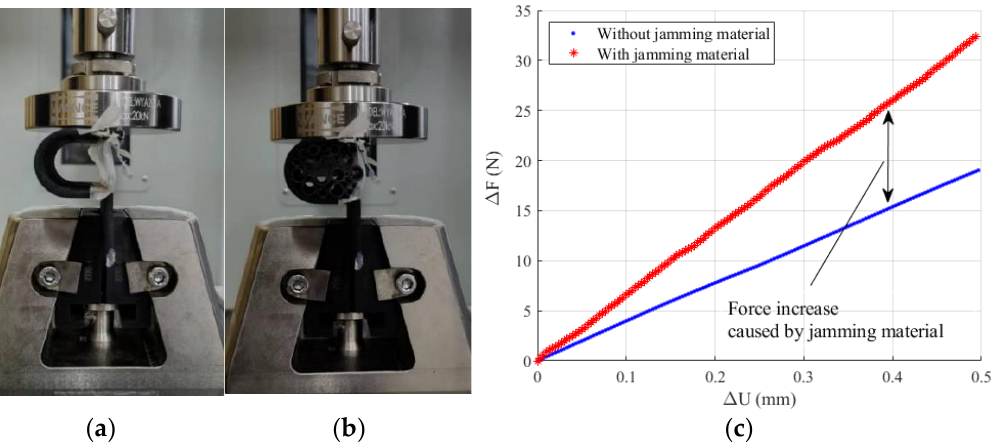
Figure 8. Compression test of a single corrugation unit: ( a ) without jamming material; ( b ) with jamming material; ( c ) change in the compression stiffness with filled jamming material.